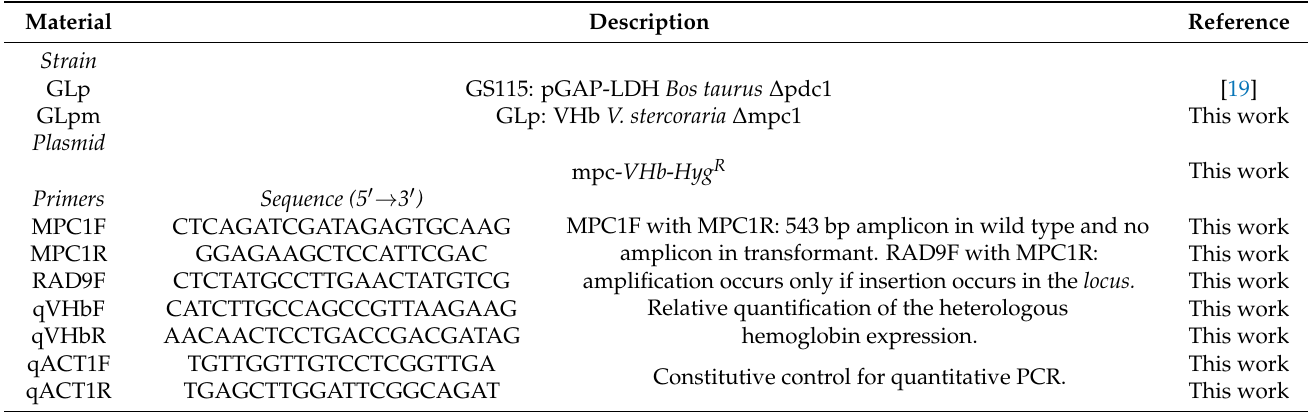
Table 1. Strain, plasmid, and primers used in this work.